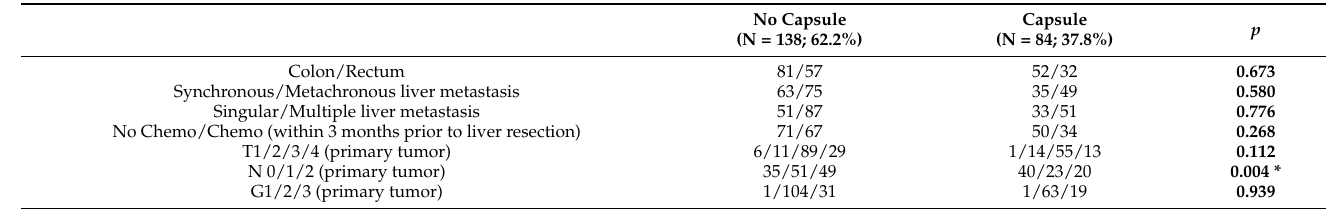
Table 2. Demographics of investigated patients with colorectal liver metastases. * p < 0.05. Some histological results for T/N/G of primary tumors are missing.